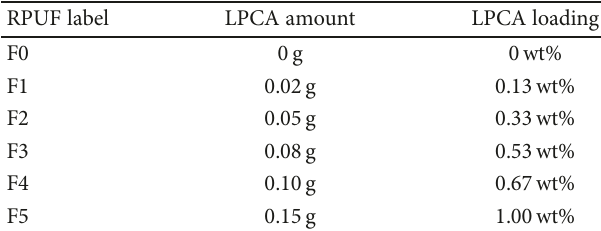
Table 1: The amount of LPCAs, the loading of LPCAs, and the label of